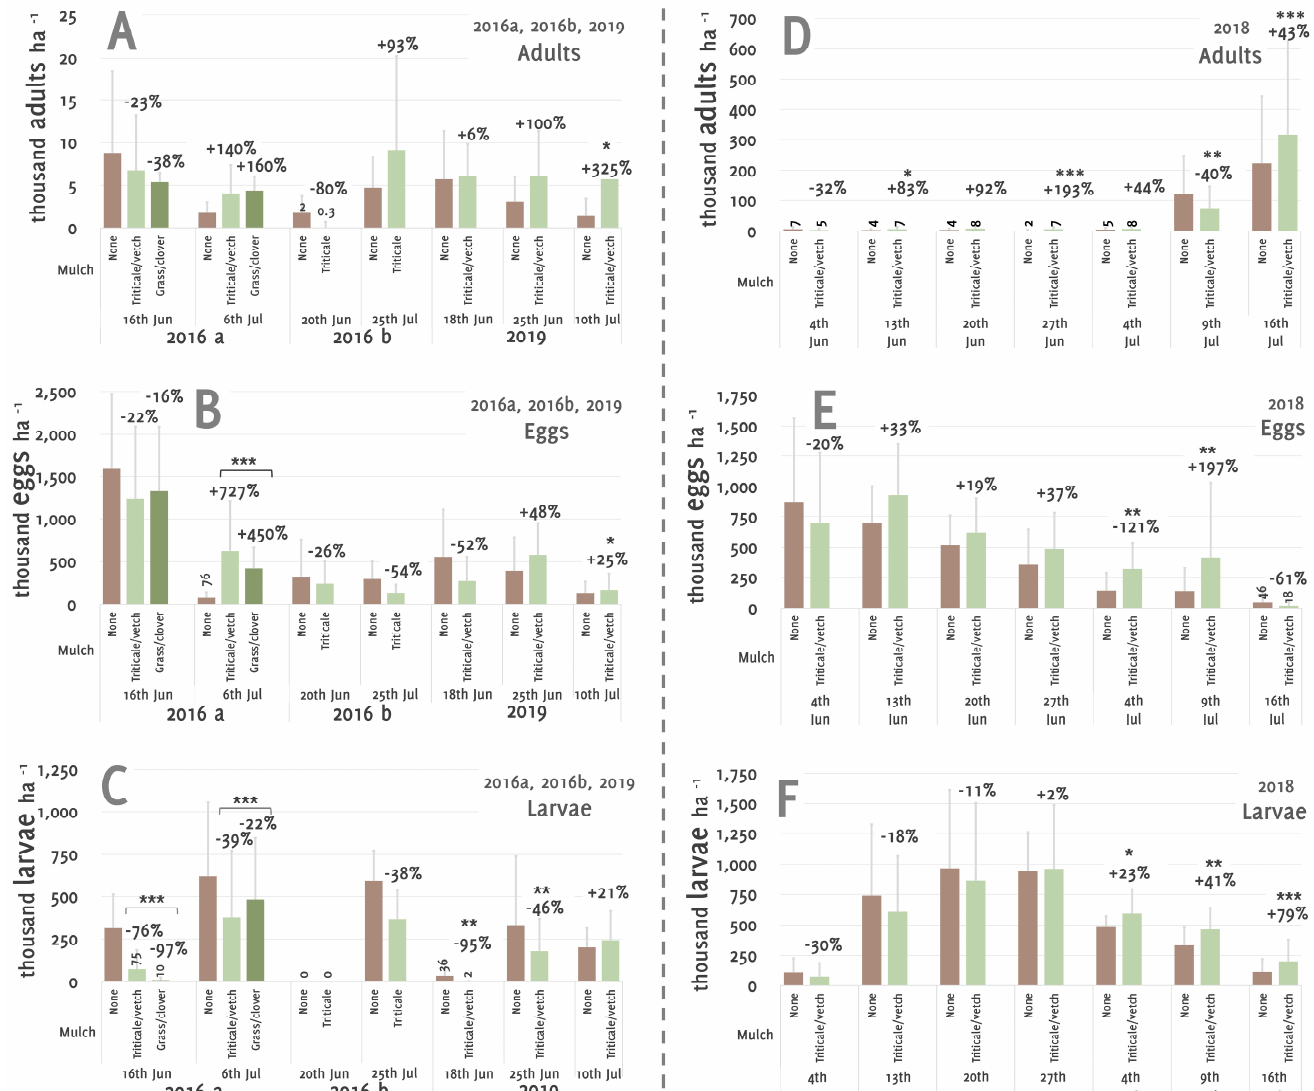
Figure 3. Effect of various mulch materials on different developmental stages ( A – C for 2016a, 2016b, 2019 and D – F for 2018) of CPB in the different experiment over the vegetation period. Relative numbers (%) show the differences between the mulched and unmulched control. Lines above the bars indicate the standard deviation in the positive direction. Statistical differences are indicated by * ( p < 0.05), ** ( p < 0.001) and *** ( p < 0.0001). Observe that the y-axes are scaled differently for 2018 compared to the other years.